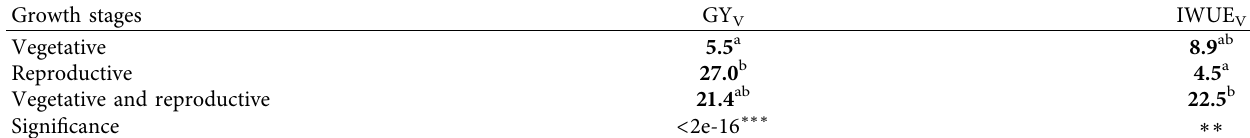
Table 1: Variation of grain yield and irrigation water use efciency across maize growth